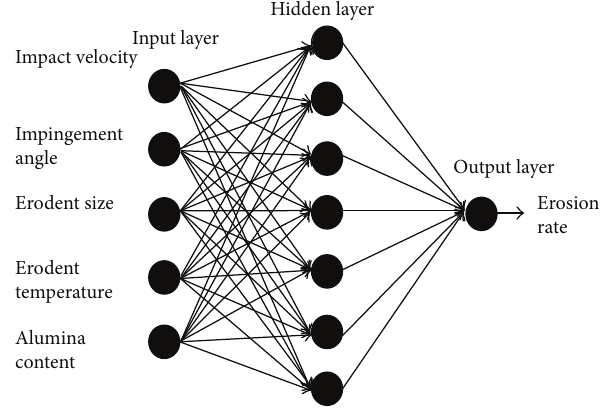
Figure 3: The three-layer neural